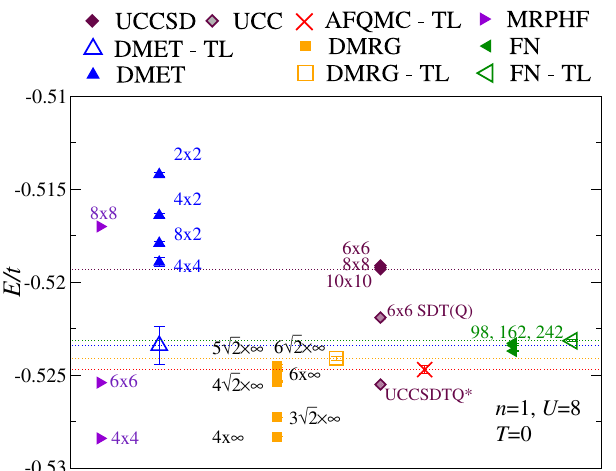
FIG. 4. Thermodynamic-limit ground-state energy for n ¼ 1 for U=t ¼ 8 as obtained by various algorithms (open symbols). Also shown are the finite-size systems (filled symbols with adjacent labels) from which the TL ground-state energy was obtained. Data are from AFQMC (red crosses), DMET (blue triangles), UCCSD (maroon diamonds), MRPHF (purple trian- gles), DMRG (orange squares), and FN (green triangles). Horizontal thin dotted lines show the best estimates for the ground-state